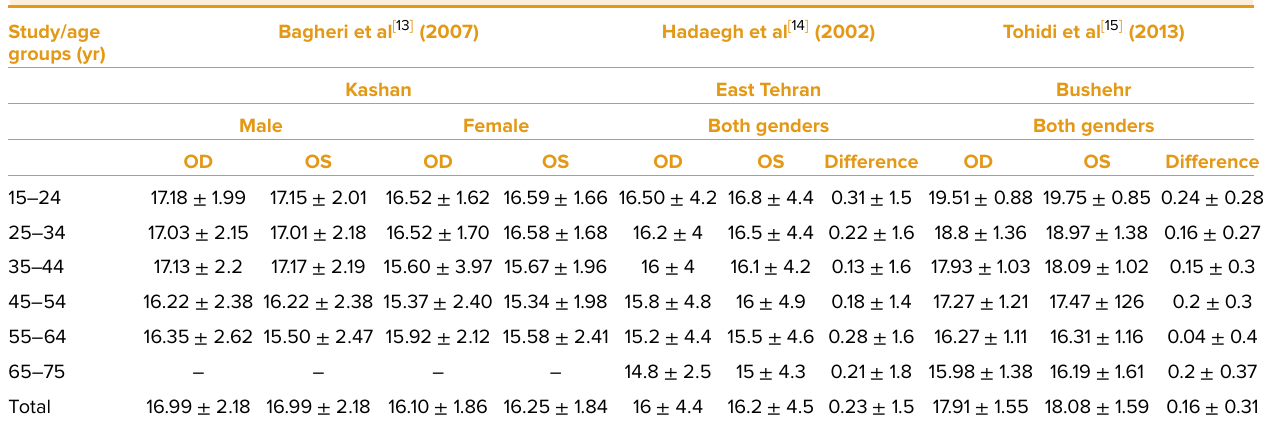
Table 1. Normal eye protrusion values from the included studies*